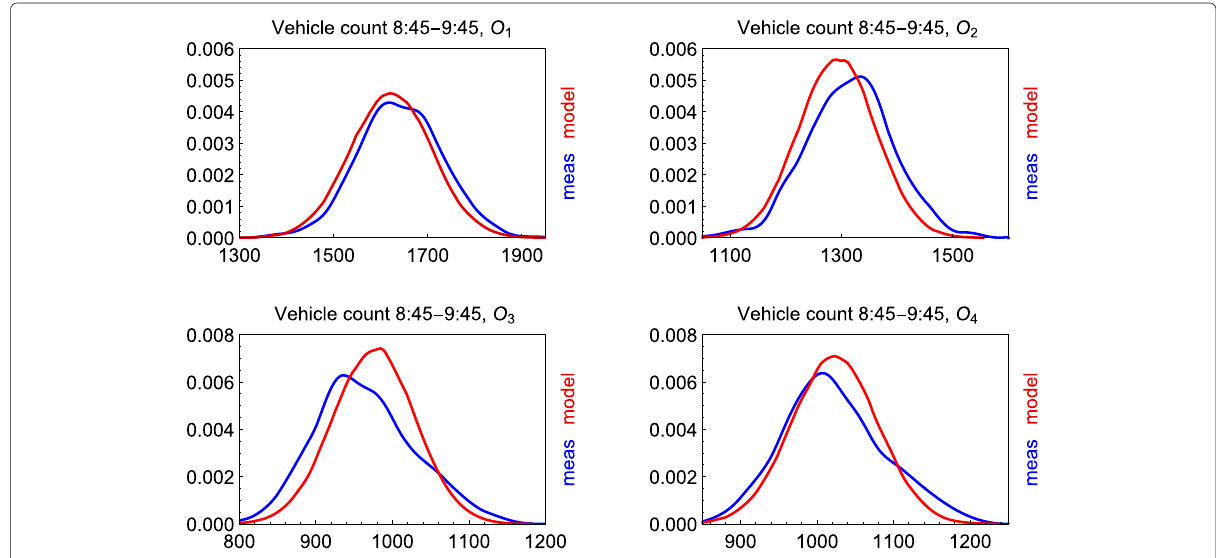
Fig. 7 Smooth histogram illustrations of traffic between 8:45 - 9:45 AM, notation as in Figure